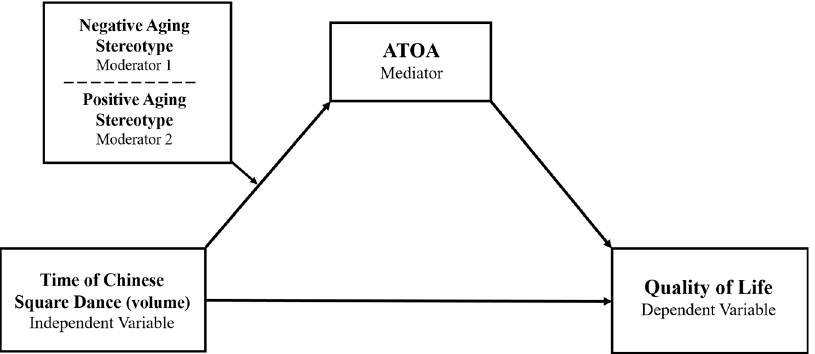
Figure 1. The hypothesized conditional process model when negative and positive aging stereotypes are separately treated as moderators.